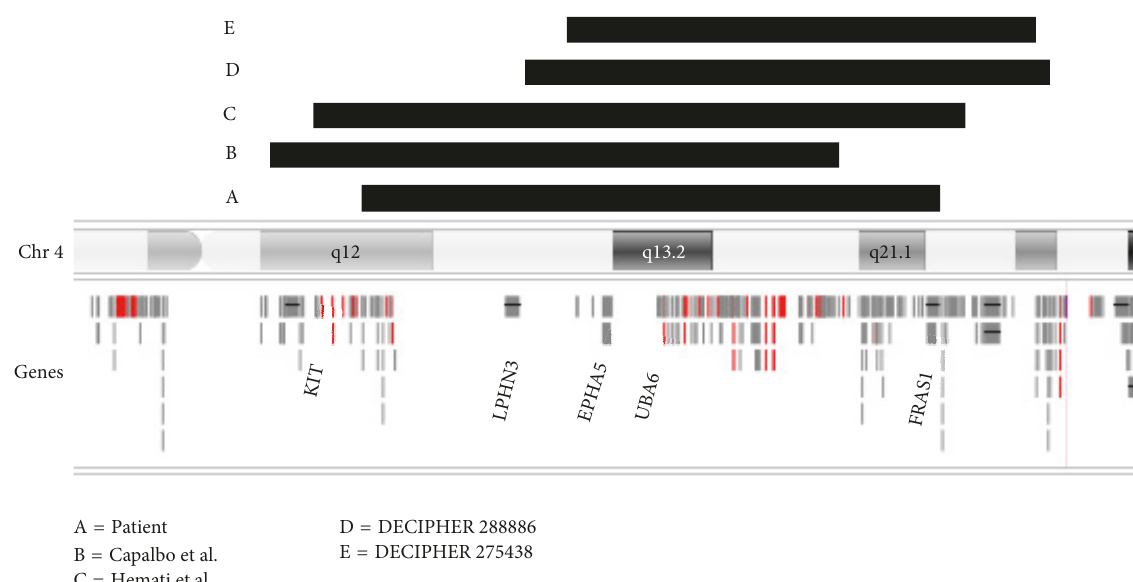
Figure 5: Comparison of 4q11-q21.1 deletion patients from the literature and